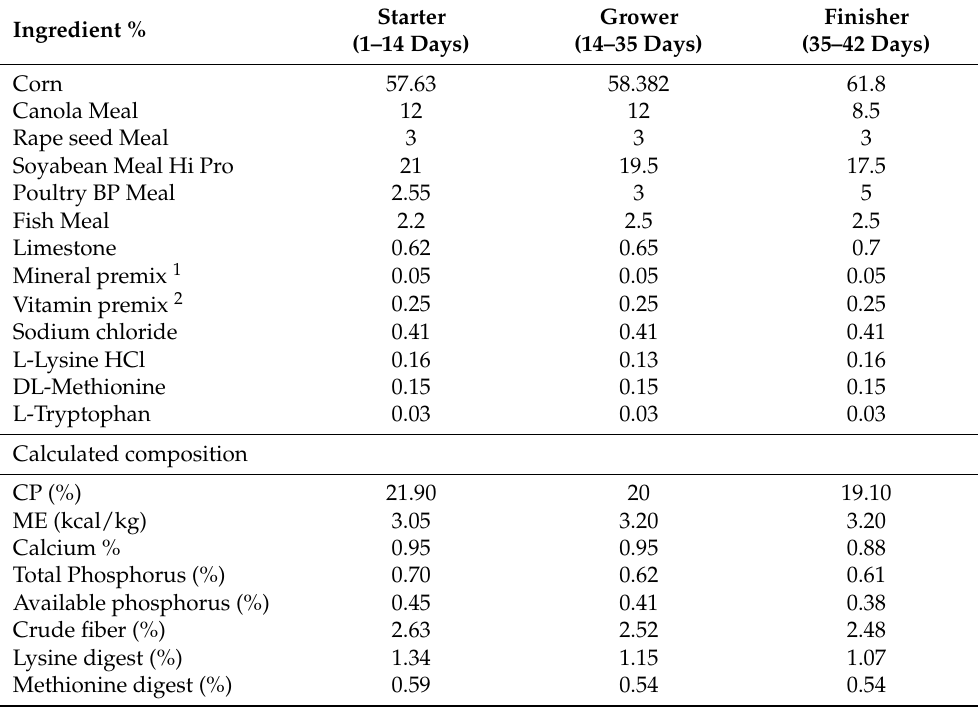
Table 1. Ingredients and nutritional value of Basal diet